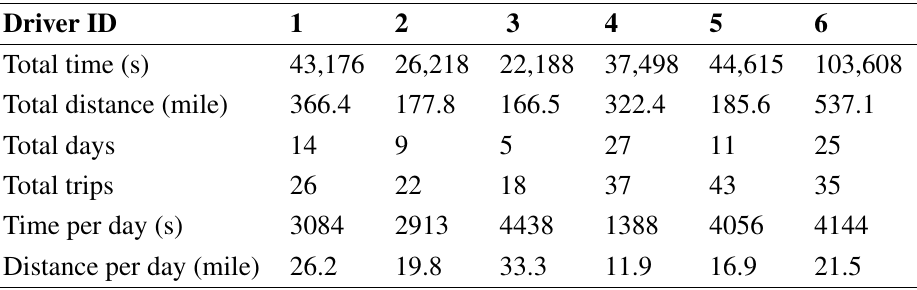
Table 2. Comparison of different participants’ driving trips.